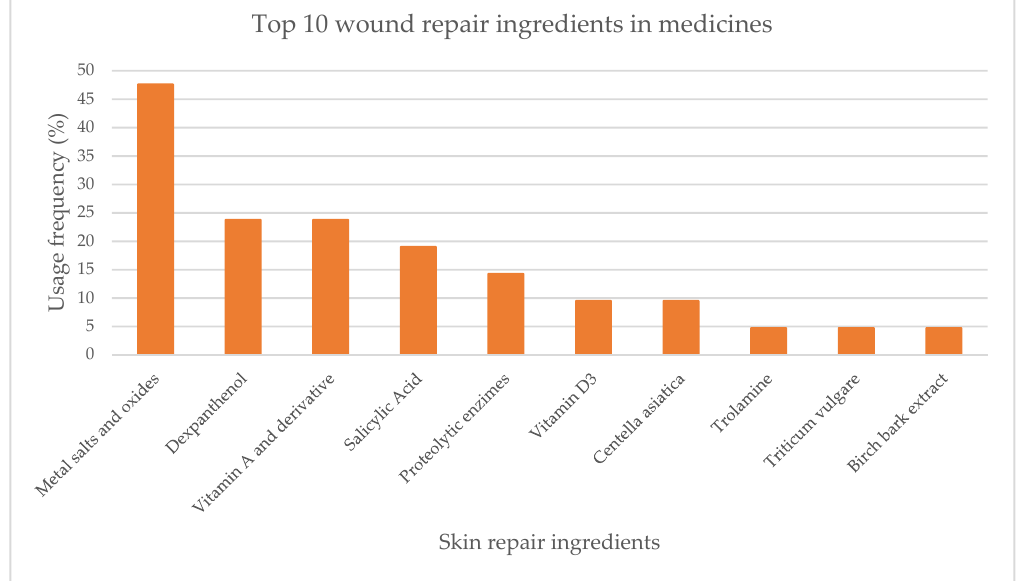
Figure 4. Usage frequency, in percentage, of the top 9 skin repair ingredients found in medicines.